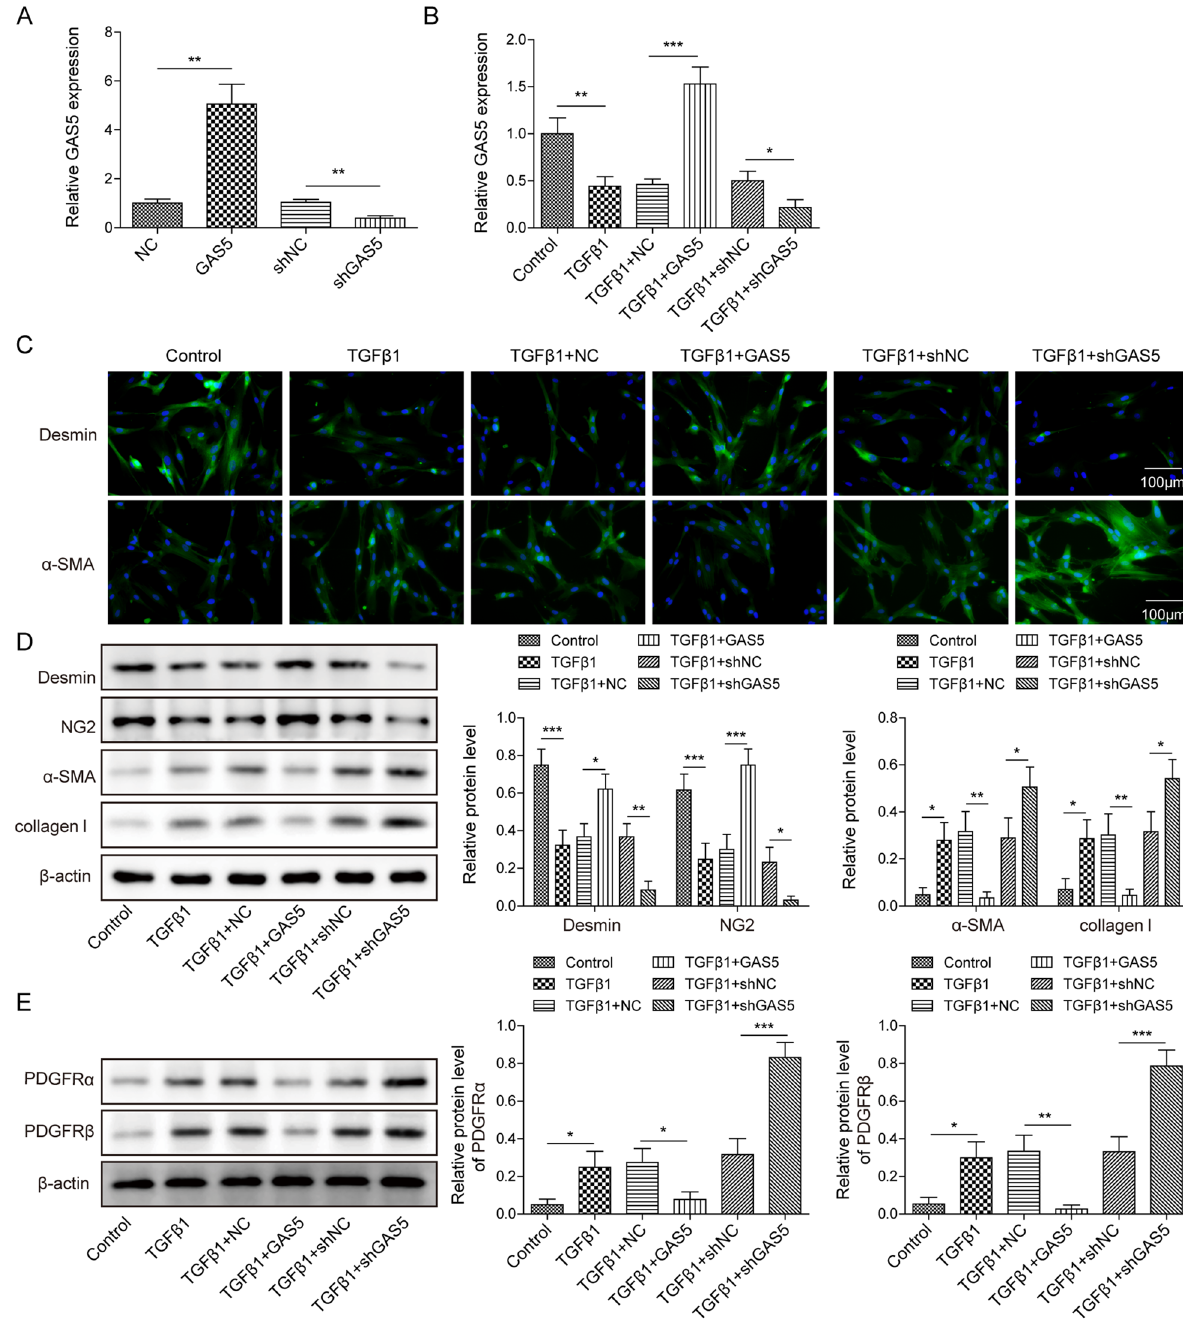
Fig. 3 GAS5 repressed the TGF-β1-induced pericyte–myofibroblast transformation. Pericytes were transfected with pcDNA3.0 containing GAS5 (GAS5) or shGAS5 and then exposed to TGF-β1 (10 ng/mL) for 12 h. They were divided into six groups: control, TGF-β1, TGF-β1 TGF-β1 GAS5, TGF-β1 shNC, and TGF-β1 shGAS5. A , B RT-qPCR examination of the GAS5 level. C Immunofluorescence staining detection of + + + desmin and α-SMA expressions. D Western blotting analysis of the protein levels of desmin, NG-2, α-SMA, and collagen I. E Western blotting was used to detect the expression of PDGFR α/β. For A–E, n 3. * P < 0.05, ** P < 0.01, *** P < =